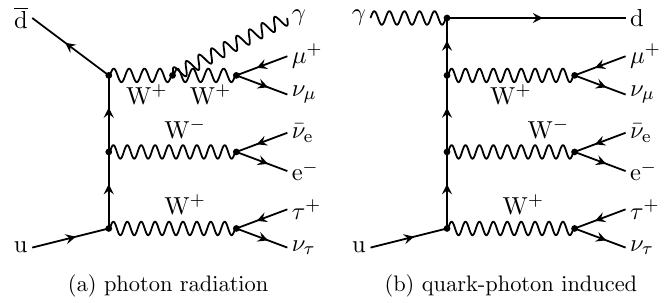
Figure 3. Examples for NLO EW real emission diagrams contributing to pp ! e (cid:0) (cid:22) (cid:23) e (cid:22) + (cid:23) (cid:22) (cid:28) + (cid:23) (cid:28) + X . d